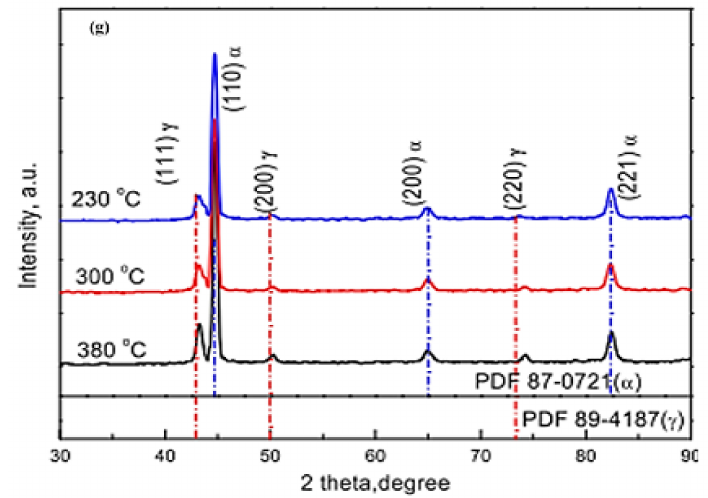
Figure 11. Secondary electron mode S.E of morphological images of the austempered specimens at ( a , b ) 230 ◦ C, ( c , d ) 300 ◦ C, and ( e , f ) 380 ◦ C and ( g ) the phase analysis of the austempered ductile iron samples [13,39].